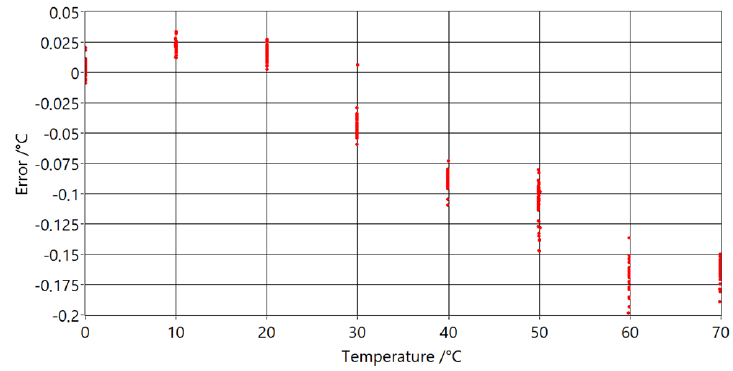
Figure 22. Temperature error versus reference temperature readings for PAT with optimal waveguide lengths.